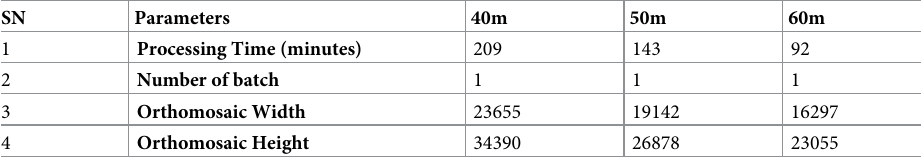
Table 2. Orthomosaic processing details for altitude